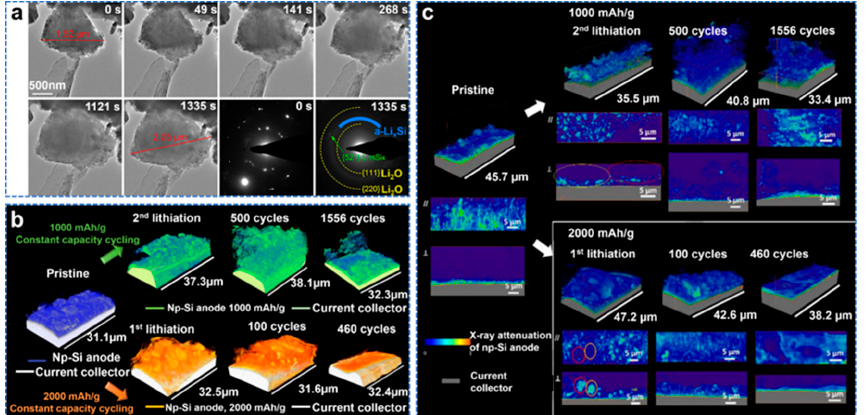
Figure 12. ( a ) In situ TEM observation of the lithiation process of a porous Si particle [125]. ( b ) X − ray nanotomography reconstruction with volume rendering shows the morphological evolution of the np − Si anode, ( c ) Quantitative material density 3D maps and pseudo cross sections from X − ray nanotomography showing electrode cycled in constant capacity mode [127].